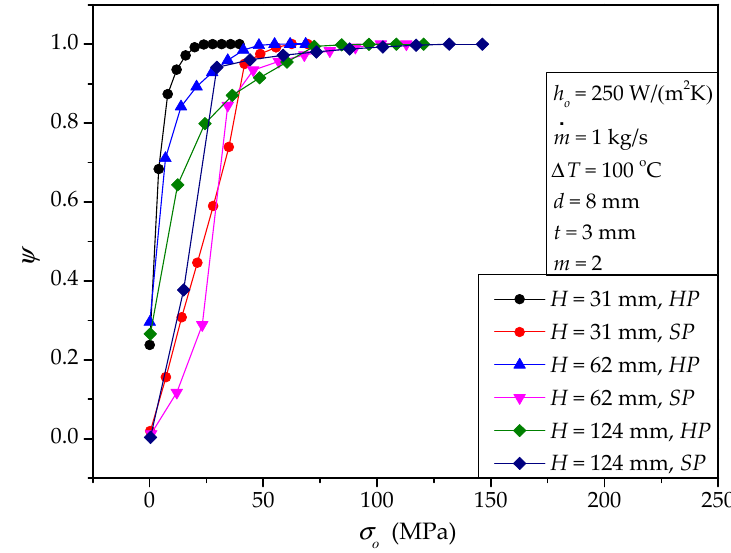
Figure 7. Cumulative von Mises stress distribution for different paddle